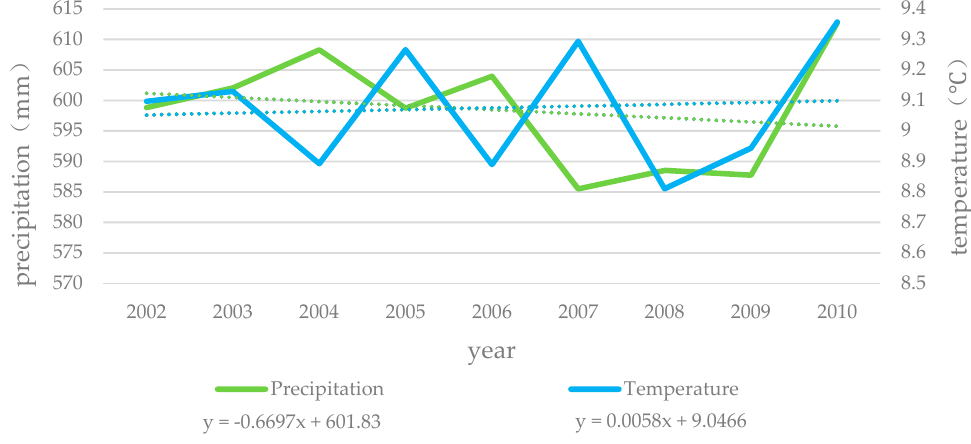
Figure 3. The trends in global temperature and precipitation.